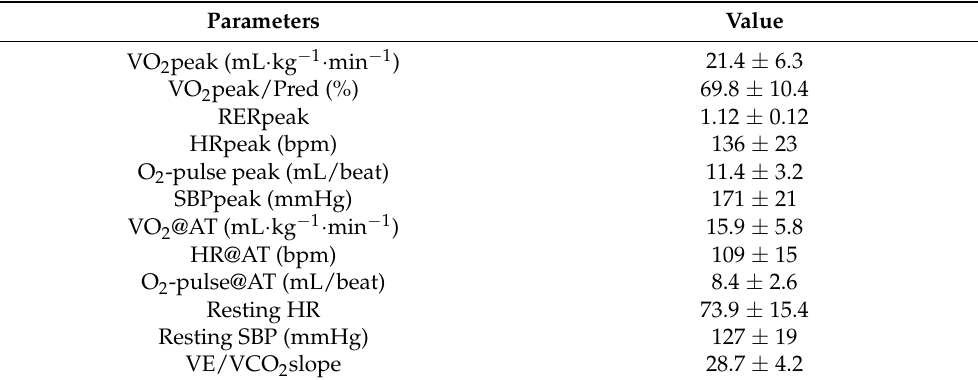
Table 2. CPET results.